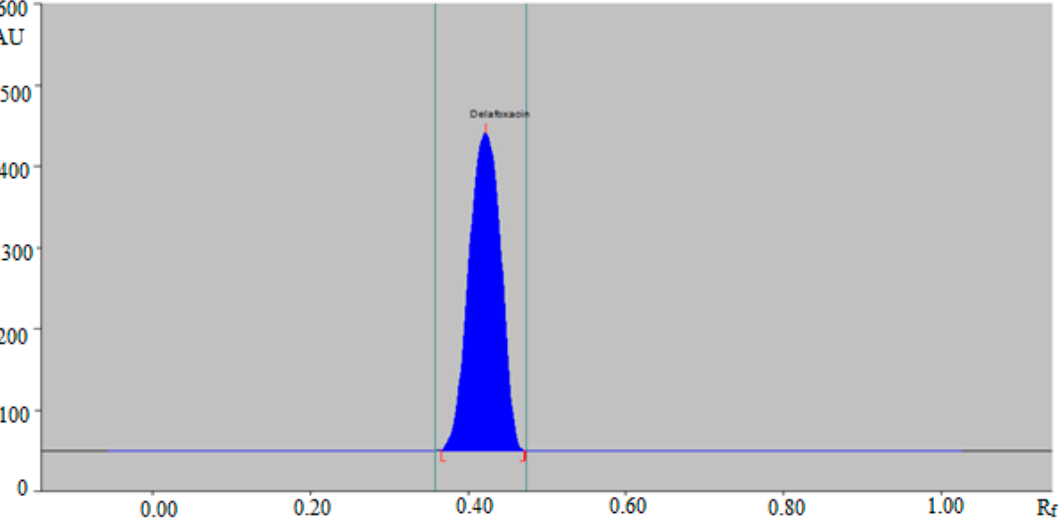
Figure 3. HPTLC chromatogram of standard DLFX by NP ‐ HPTLC method.